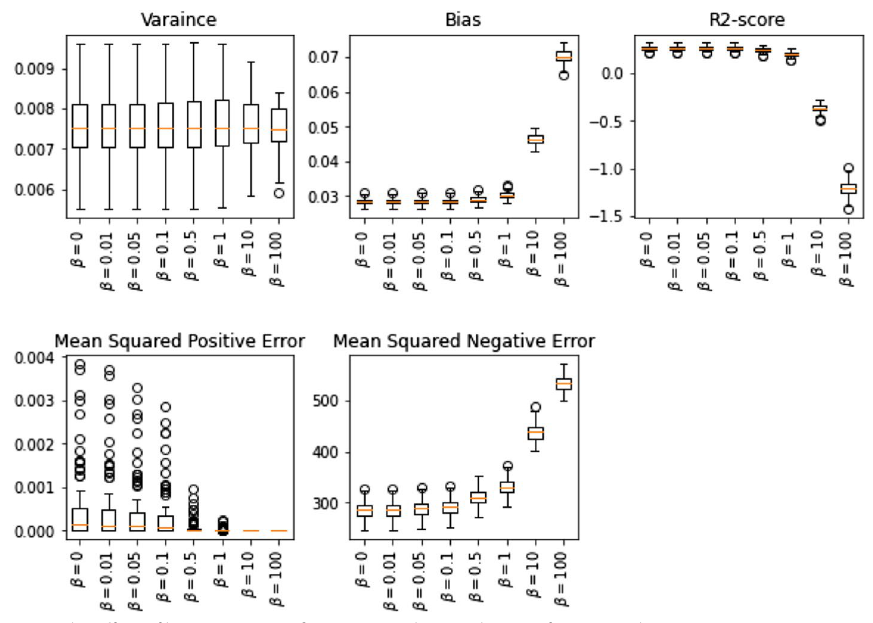
Fig. 1 The effect of hyperparameter β on variance, bias, and score of univariate linear regression